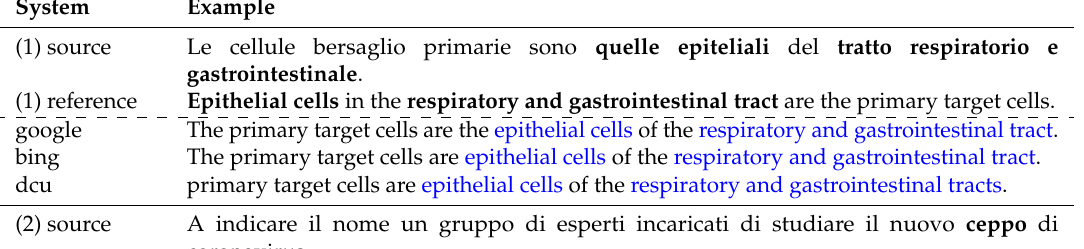
Table 12. Translation examples for